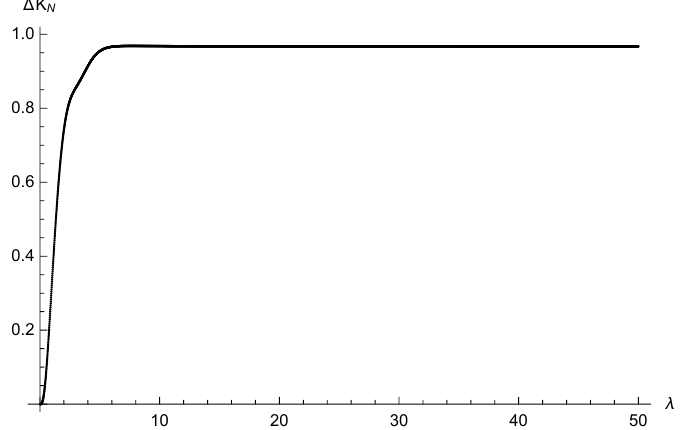
Figure 4. ∆ K N as a function of λ , considering H 2 and the initial conditions